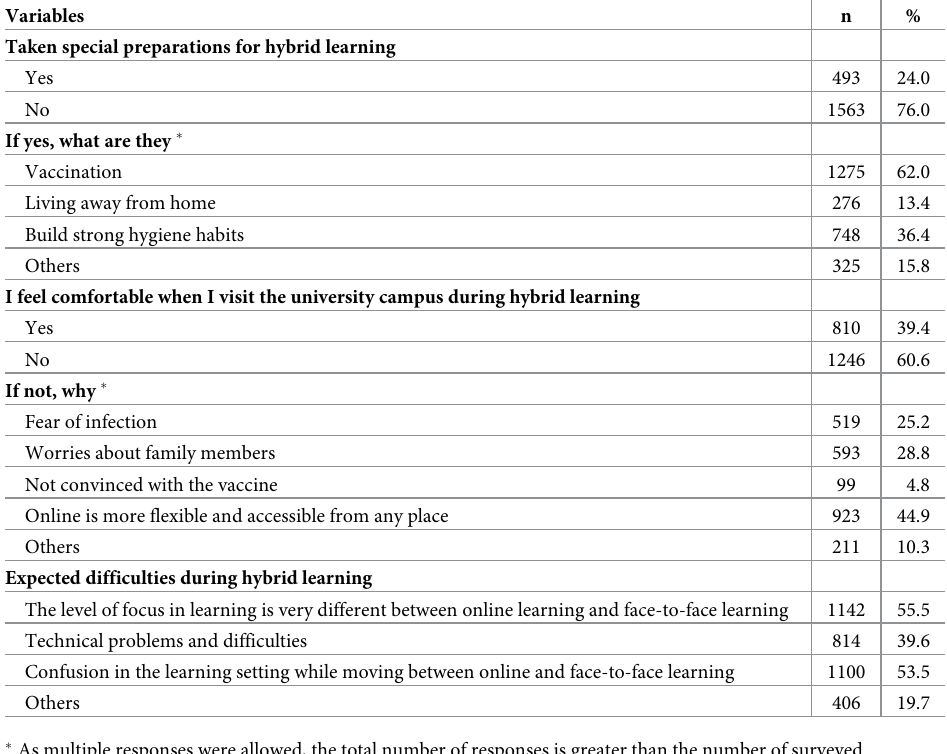
Table 4. Students’ concerns and readiness for hybrid learning (n =